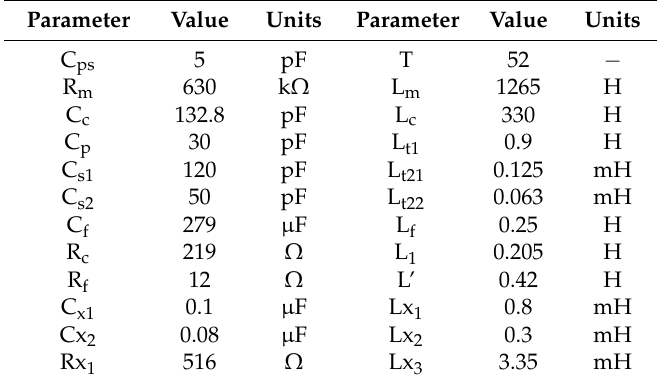
Table 3. Values of the lumped elements of the “TRIAL#2” equivalent circuit. Parameter